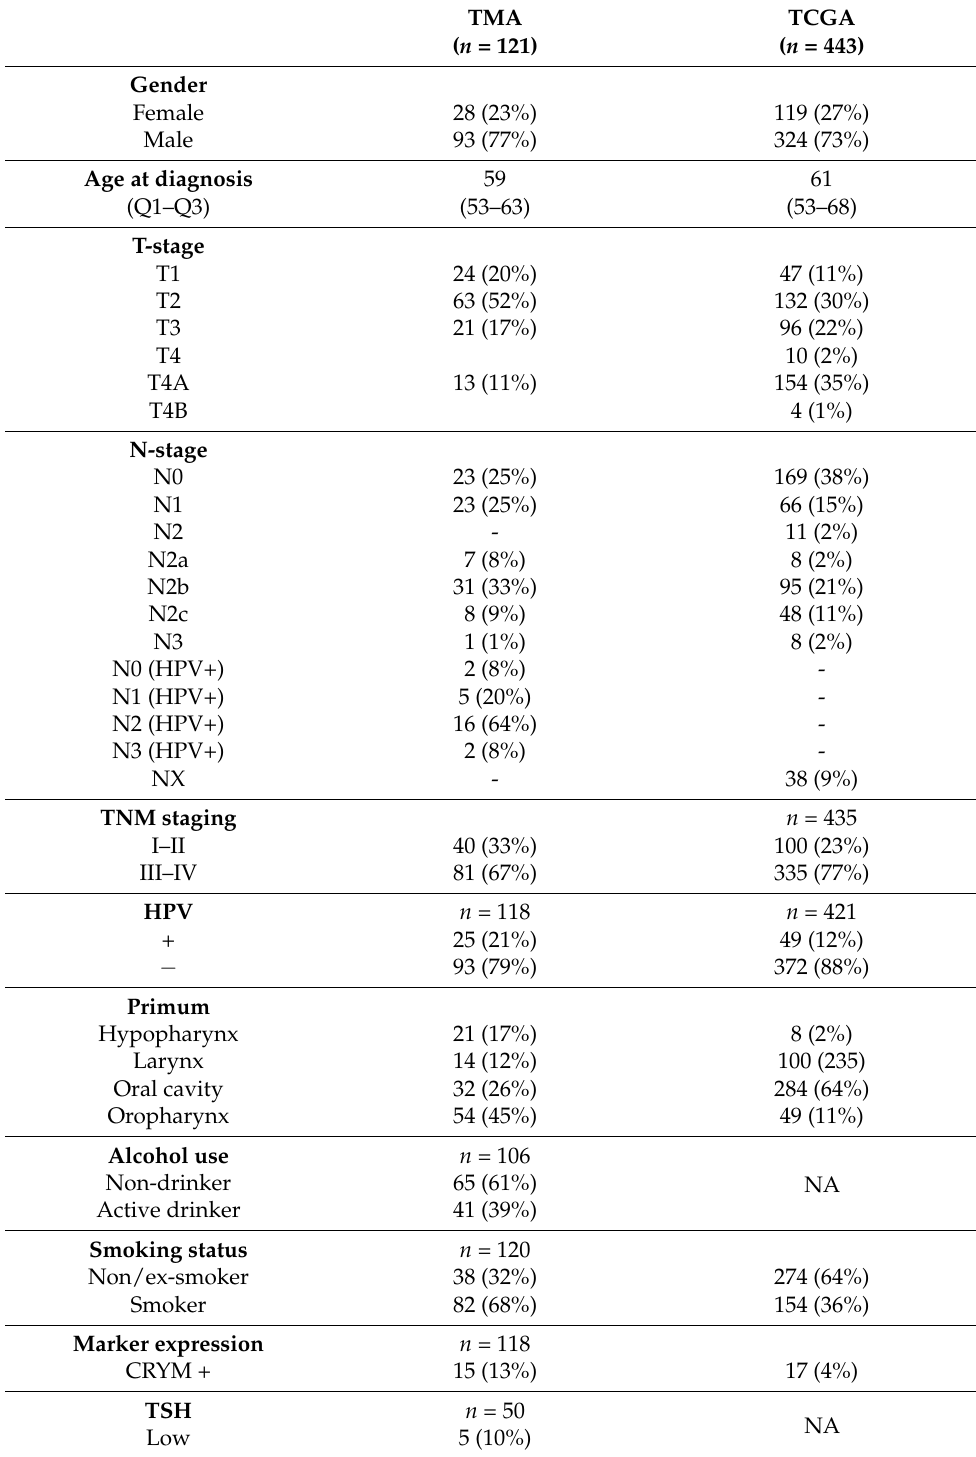
Table 1. Baseline characteristics of the study population for the primary and secondary dataset. NA, not